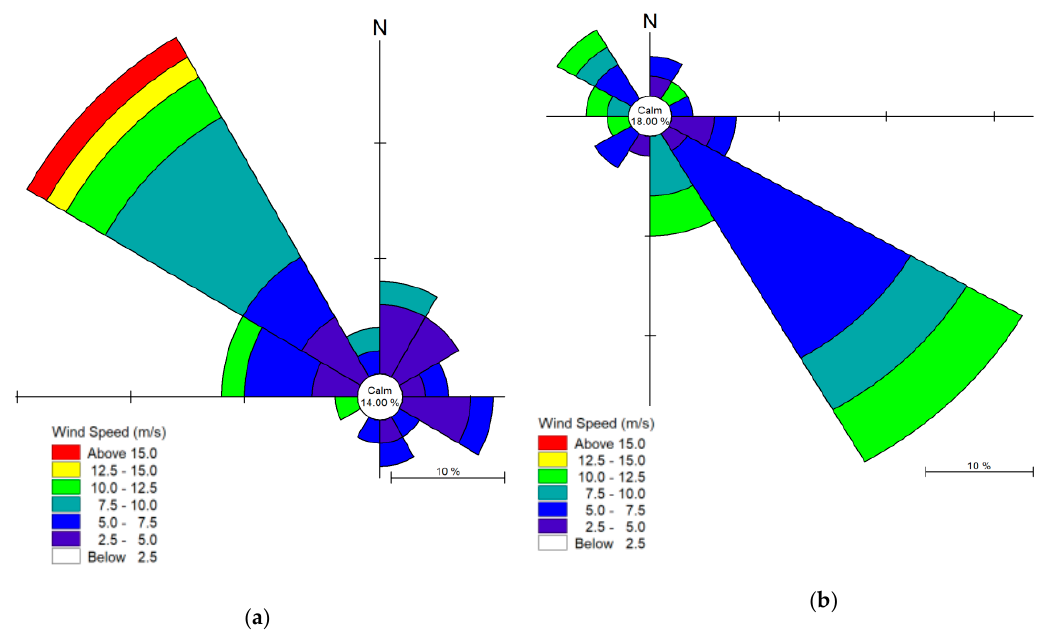
Figure 3. Wind roses in 2015: ( a ) NE season; ( b ) SW season (sources of data: Malaysian Department of Meteorology).